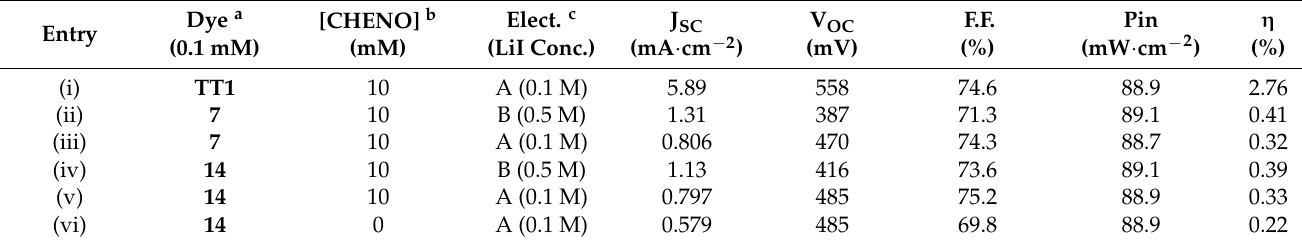
Table 3. Photovoltaic data of the best DSSCs sensitized with Pz- 7 , 14 and benchmark TT1 under simulated AM1.5G illumination (~0.9 sun intensity).